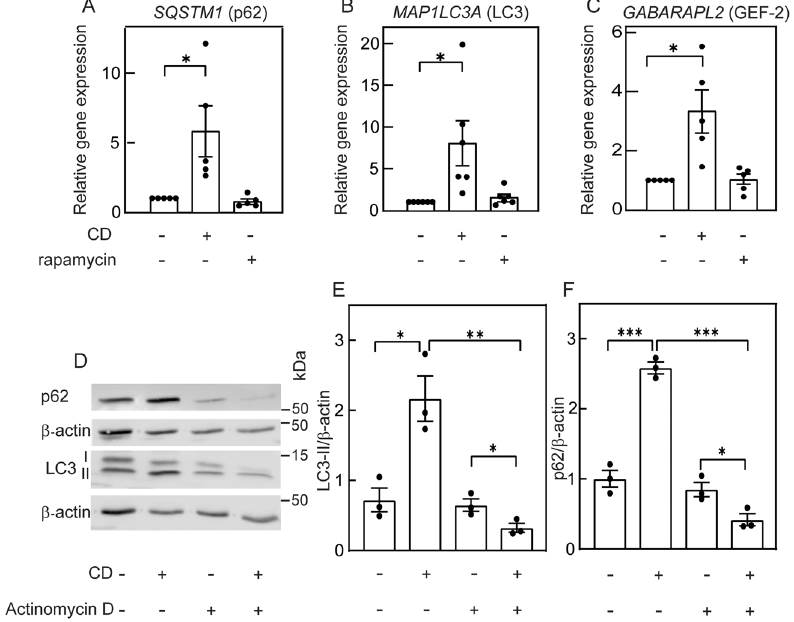
Fig. 5 Cholesterol depletion-mediated increase in mRNA levels of autophagy markers is not essential for autophagy induction. A – C RT- qPCR analysis of A SQSTM1 (encodes for p62); B MAP1LC3 (encodes for LC3); and C GABARAPL2 (encodes for GEF-2). Mv1Lu cells were treated (or not) for CD by statin or with rapamycin as in Fig. 4. RT-qPCR was as described under “ Materials and methods ” . Data (mean ± SEM; 5 or 6 independent experiments in each case) were normalized to the cDNA levels of β -actin, taking the level of the respective mRNA in untreated cells (control) as 1. The mRNA levels were signi fi cantly elevated in cholesterol-depleted cells, but were not affected by rapamycin treatment (* P < 0.05, Student ’ s two-tailed t -test). D – F Induction of autophagy by CD persists in the presence of actinomycin D. Cells were treated (or not) for CD by statin in the absence or presence of actinomycin D (1 μ g/ml, added together with the statin). After 16 h, cells were lysed and analyzed by immunoblotting for LC3 and p62, using β -actin as loading control. D A representative blot. E , F Quanti fi cation of LC3-II ( E ) and p62 ( F ) levels relative to β -actin. The level measured for the control sample (untreated cells) was taken as 1. Bars are mean ± SEM of 4 independent experiments (* P < 0.05; *** P < 0.001; Student ’ s two-tailed t -test). Cell Death Discovery (2021)